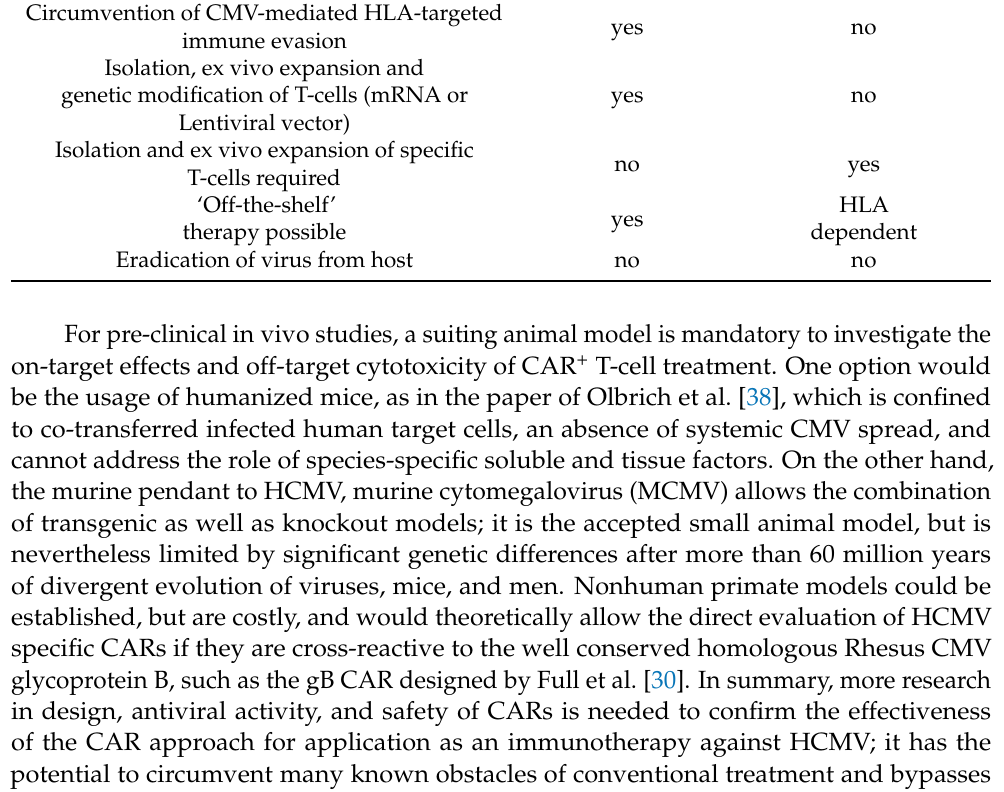
Table 1. Comparison of antiviral CAR T-cells with conventional antigen-specific T-cell therapy. CAR Antigen Specific T-Cell Therapy T-Cell Therapy Antigen-specific yes yes target cell recognition HLA-independent mode of action yes no HLA-matching required no partial match Seronegative donor possible yes no Circumvention of CMV-mediated HLA-targeted immune evasion Isolation, ex vivo expansion